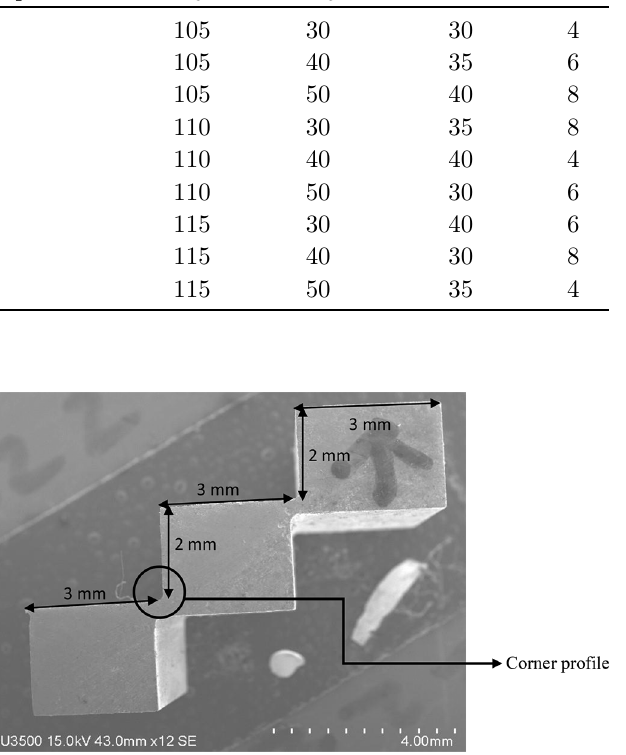
Fig. 2. Machining pro fi le of the workpiece.